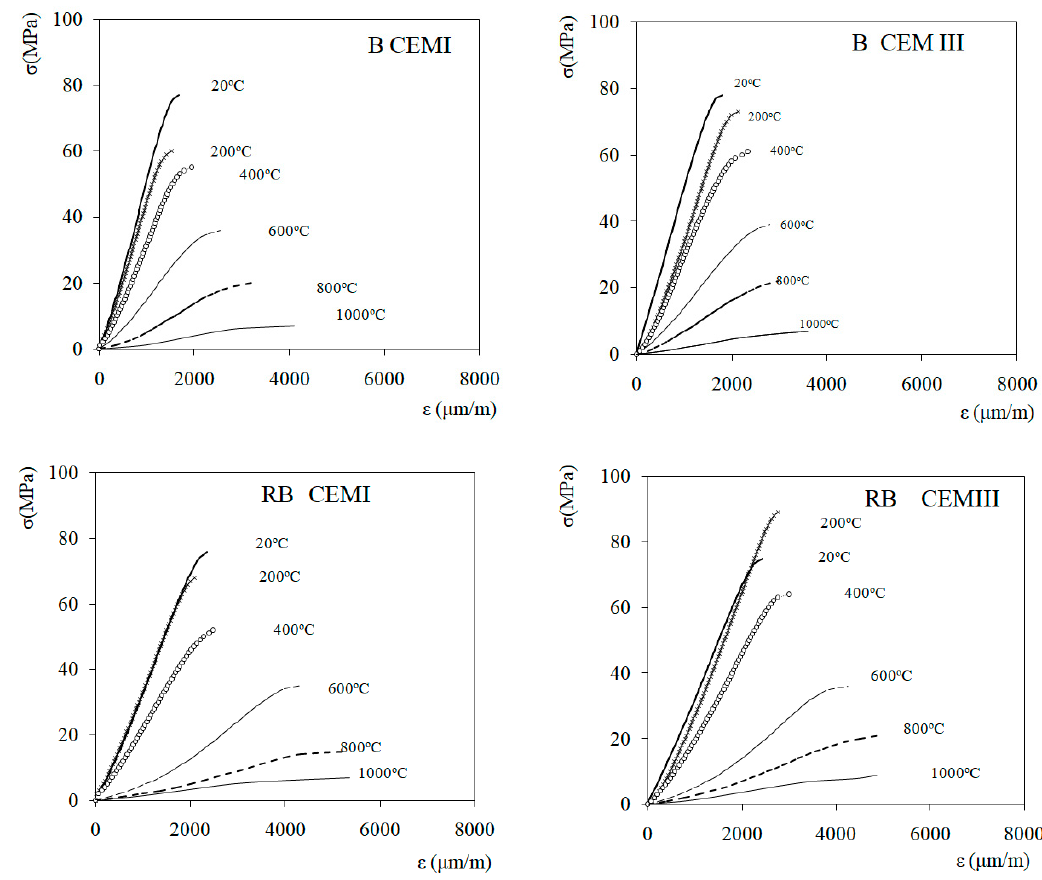
Figure 5. curves of heated concretes. Materials 2019 , 12 , x FOR PEER REVIEW